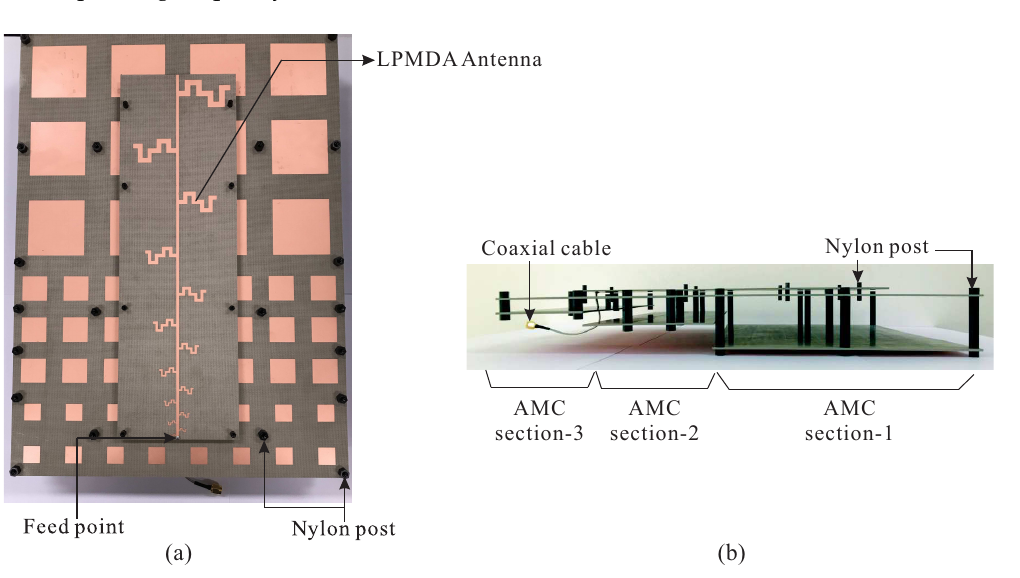
Figure 7. Photograph of the fabricated antenna: ( a ) Top-view; ( b ) Side-view.